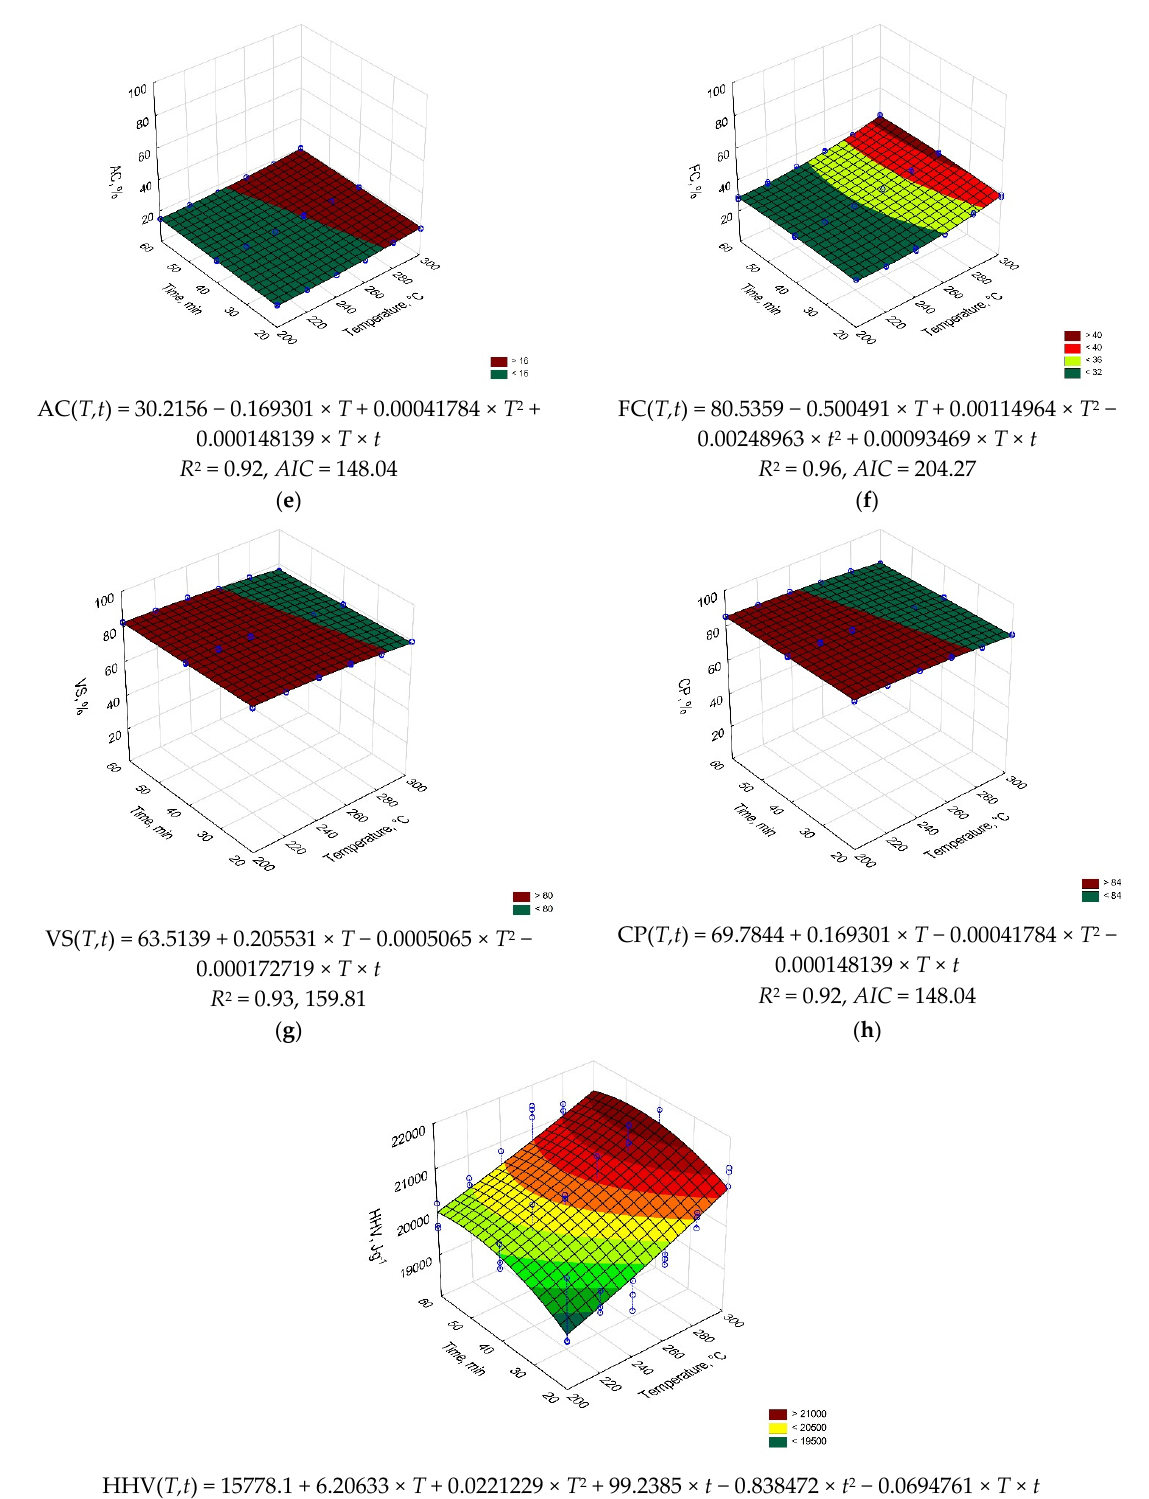
Figure A1. Torrefaction temperature and time effect on properties of CSF produced from medical/cosmetic peat waste, the equations boundary, T = 200–300 ◦ C, t = 20–60 min. ( a ) mass yield, ( b ) energy densification ratio, ( c ) energy yield, ( d ) volatile matter, ( e ) ash content, ( f ) fixed carbon, ( g ) volatile solids, ( h ) combustible parts, ( i ) high heating